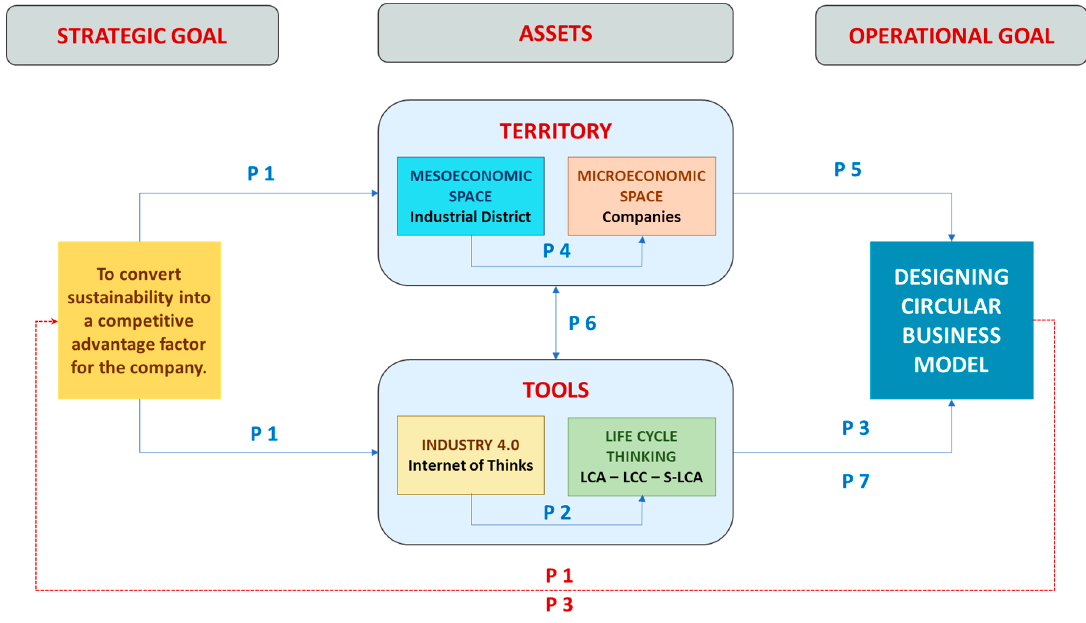
Figure 1. Conceptual model for the integration of sustainability into the business model of a company in an industrial district.